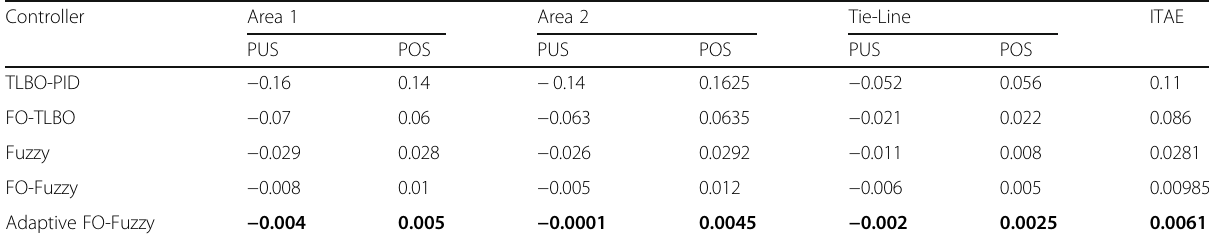
Table 6 Comparative study of various controllers for scenario 3 Controller Area 1 Area 2 Tie-Line PUS POS PUS POS PUS POS TLBO-PID − 0.16 0.14 − 0.14 FO-TLBO − 0.07 Fuzzy − 0.029 FO-Fuzzy − 0.008 0.01 Adaptive FO-Fuzzy −